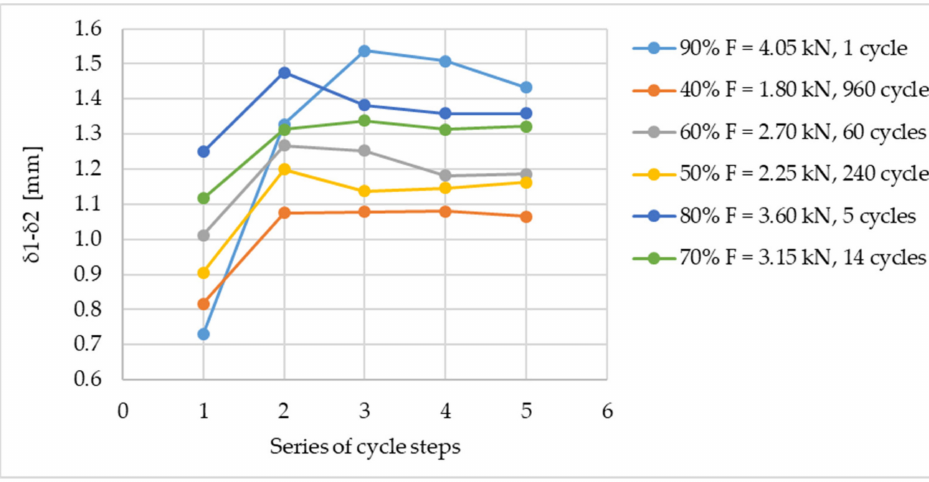
Figure 11. Opening of the notch, sharp notch specimen